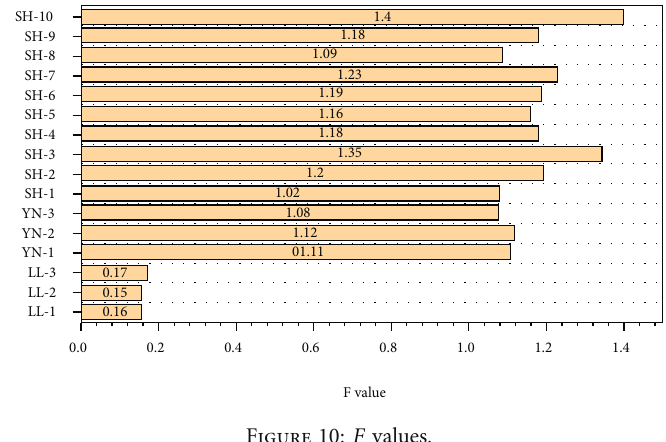
Figure 10: F values. Table 3: Network